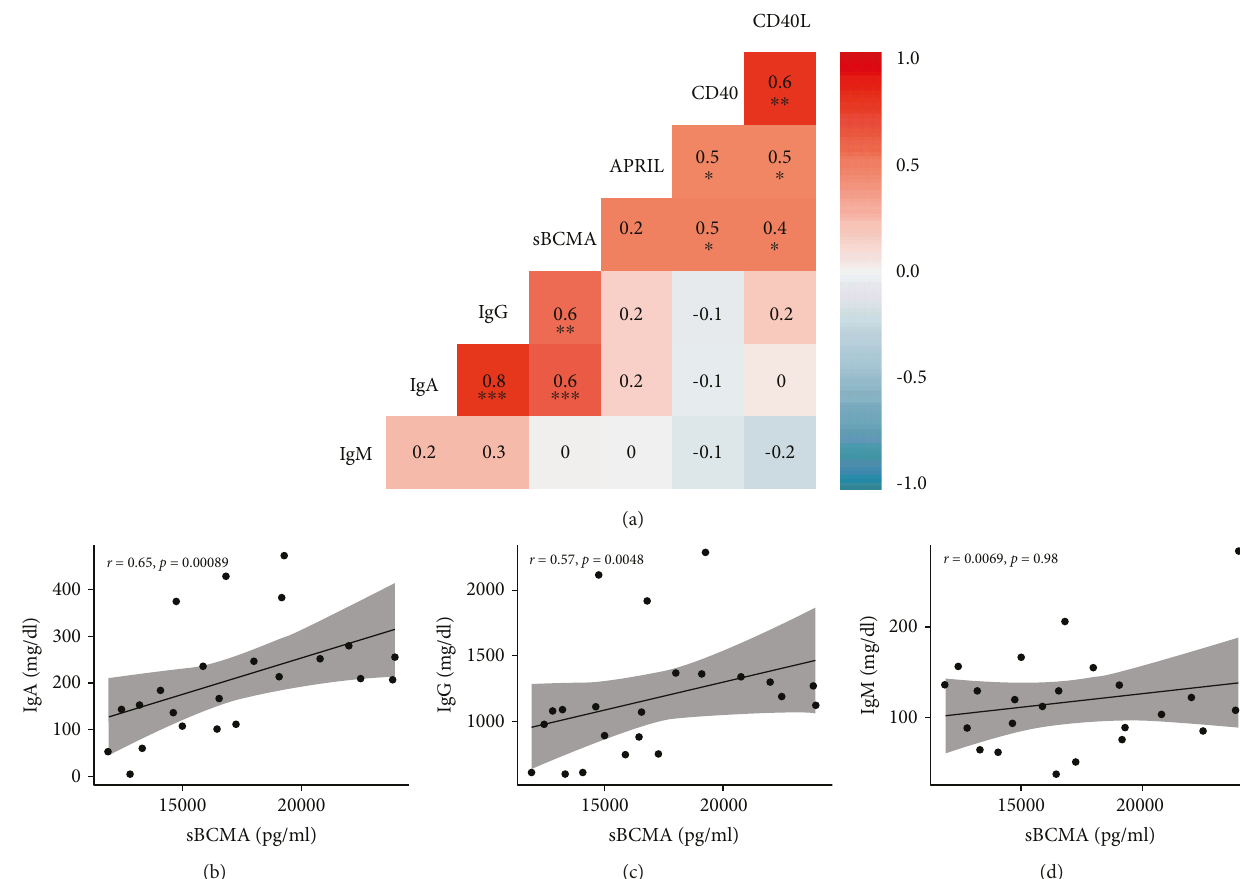
Figure 3: Correlation of B-cell factors and immunoglobulins in RA patients. (a) Spearman correlation matrix of soluble B-cell factors and Ig levels in RA. (b-d) Scatter plots demonstrating individual correlations between sBCMA and IgA (b), IgG (c), and IgM (d). Serum sBCMA (but not CD40, CD40L, or APRIL) had a positive correlation with serum IgG ( rho = 0 6 , p < 0 01 ) and IgA ( rho = 0 6 , p < 0 001 ), both ASC-derived class-switched antibodies, but not with IgM levels which is produced without class-switching. Moderate correlations were also seen between B-cell activation factors (CD40, CD40L) and sBCMA levels. ∗ p < 0 05, ∗∗ p < 0 01, and ∗∗∗ p < 0 001